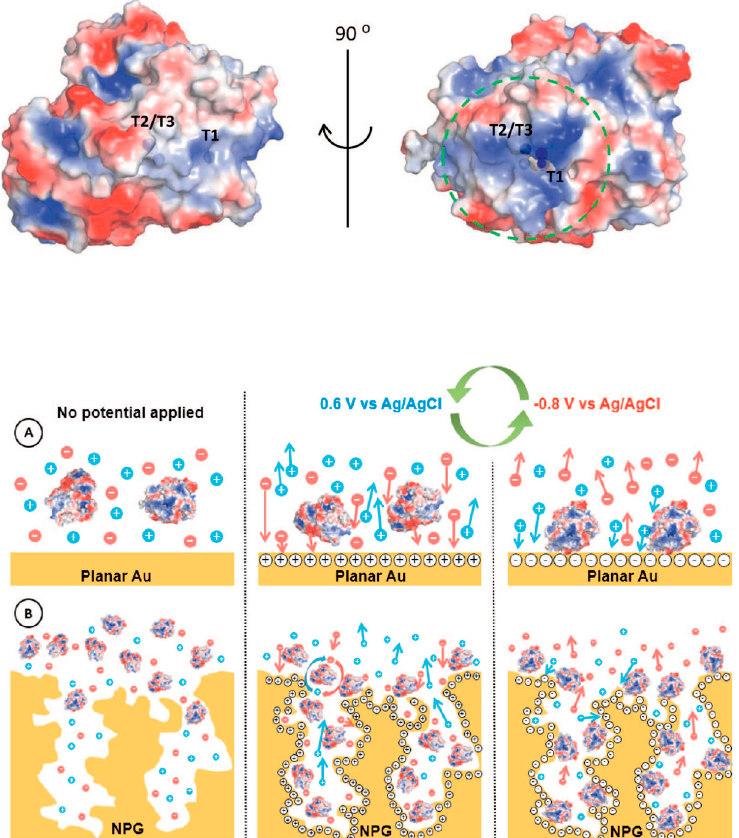
Figure 7. Surface charge distribution pattern of (PBD 2XLL) Myrothecium verrucaria BO x (blue and red colors symbolize positive and negative charges, respectively). Potential pulse-assisted immobilization approach at ( A ) planar gold and ( B ) nano-PG electrodes. The green arrows indicate the changes in the potential pulses of below and above pzc values. Reproduced with permission from [113]. Copyright